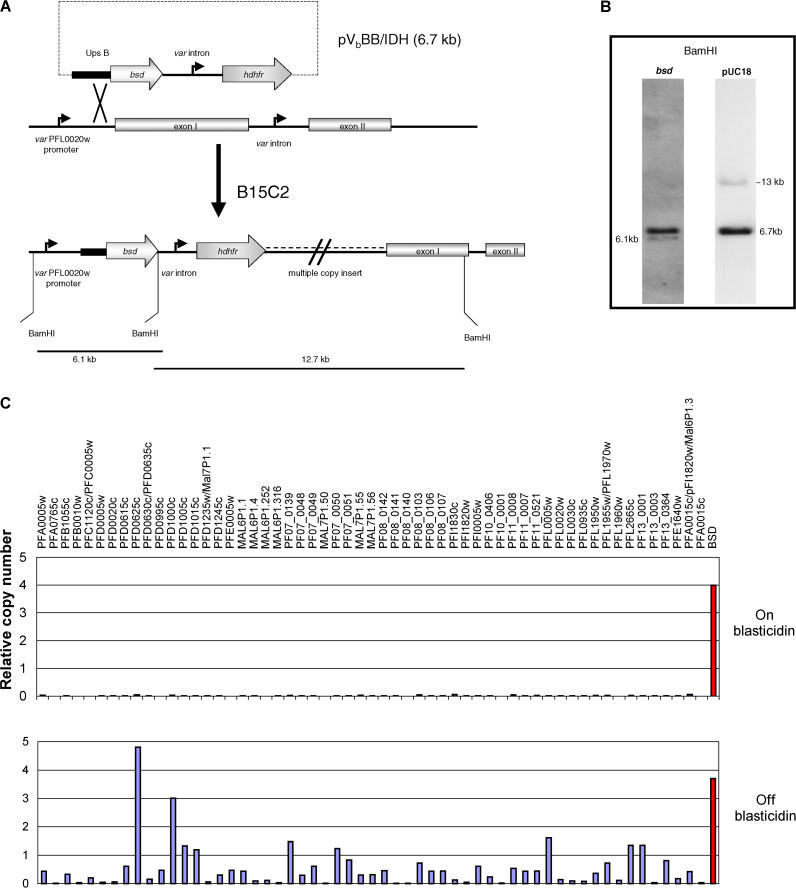
Integration of the bsd Expression Cassette into a Telomeric var Locus(A) Schematic diagram showing integration of the construct pVbBB/IDH into the var PFL0020w locus through a single homologous recombination event within the var upstream region.(B) Southern analysis was performed using BamHI-digested gDNA and hybridized with probes specific to bsd and pUC18. The linearized plasmid within the multiple copy concatameric insertion appears as a high intensity 6.7 kb band with both probes. The 6.1-kb bsd band and the ~13-kb pUC18 band correspond to fragments flanking the site of integration. This arrangement was confirmed by additional Southern blots and by sequencing across the sites of integration.(C) Analysis of the level of transcription from each var gene in the genome shows that selection for bsd expression results in silencing of the entire gene family. The only “on” gene in parasites growing under drug pressure (top panel) is the locus expressing the bsd cassette. Analysis performed 10 wk after drug removal demonstrated that the culture has become transcriptionally heterogenous (bottom panel) with the majority of the genes upregulated, of which nine are expressed at levels greater than the control (relative copy number > 1).